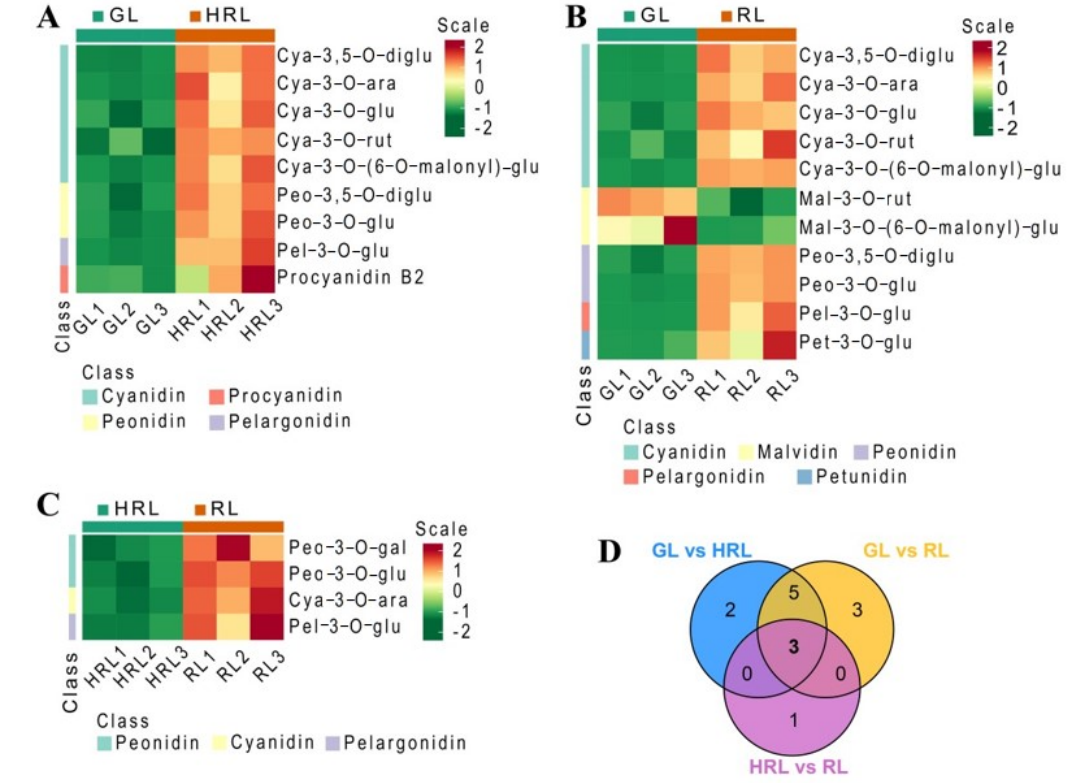
Figure 3. Differentially accumulated metabolites in the pathway of anthocyanin biosynthesis in three comparison groups: ( A ) green versus orange leaves (GL vs. HRL), ( B ) green versus red leaves (GL vs. RL), and ( C ) orange versus red leaves (HRL vs. RL). ( D ) Venn diagram of DAMs.